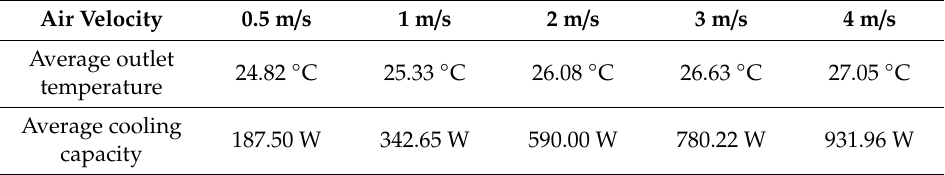
Table 5. The average outlet temperatures and cooling